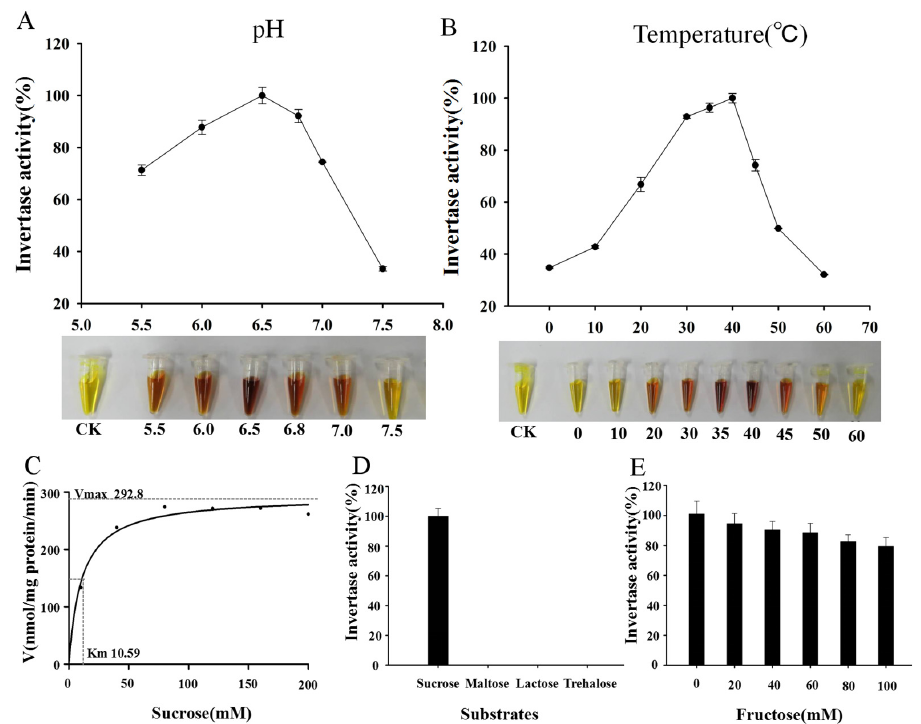
Figure 2. Enzymatic characteristics of MeNINV1. ( A ) The optimal pH of MeNINV1 determined through the DNS method. ( B ) The optimal temperature of MeNINV1 determined through the DNS method. ( C ) The enzymatic activity of MeNINV1 in different sucrose concentrations. ( D ) The enzymatic activity of MeNINV1 in different substrates. ( E ) Inhibition of the enzymatic activity of MeNINV1 by fructose. Data are the mean ± SD of three independent assays. Table 1. Effects of metal ions and chemicals on the activity of MeNINV1.